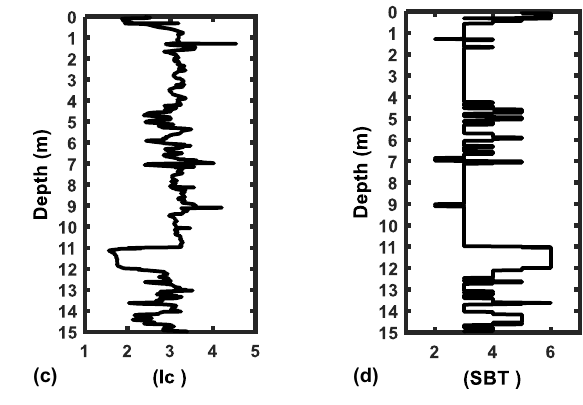
Figure 2: Distribution of basic parameters with depth.